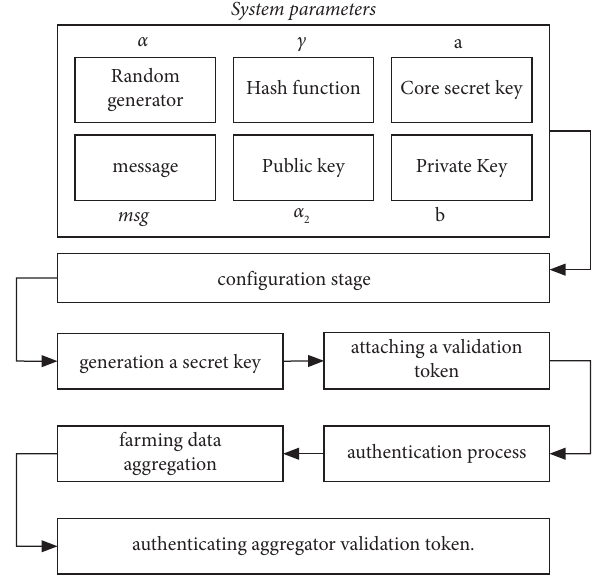
Figure 1: Block diagram of the proposed